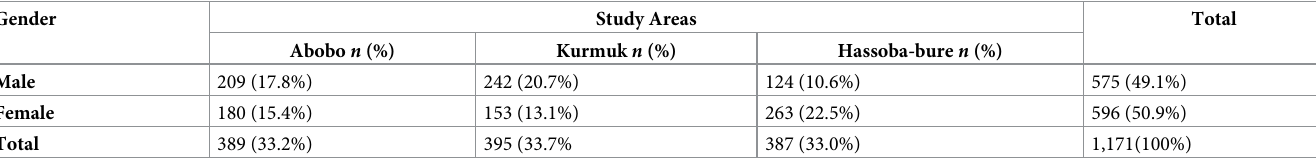
Table 1. Sex distribution of study participant’s in three study areas, Abobo, Hassoba and Kurmuk village, Ethiopia, 2021. Gender Study